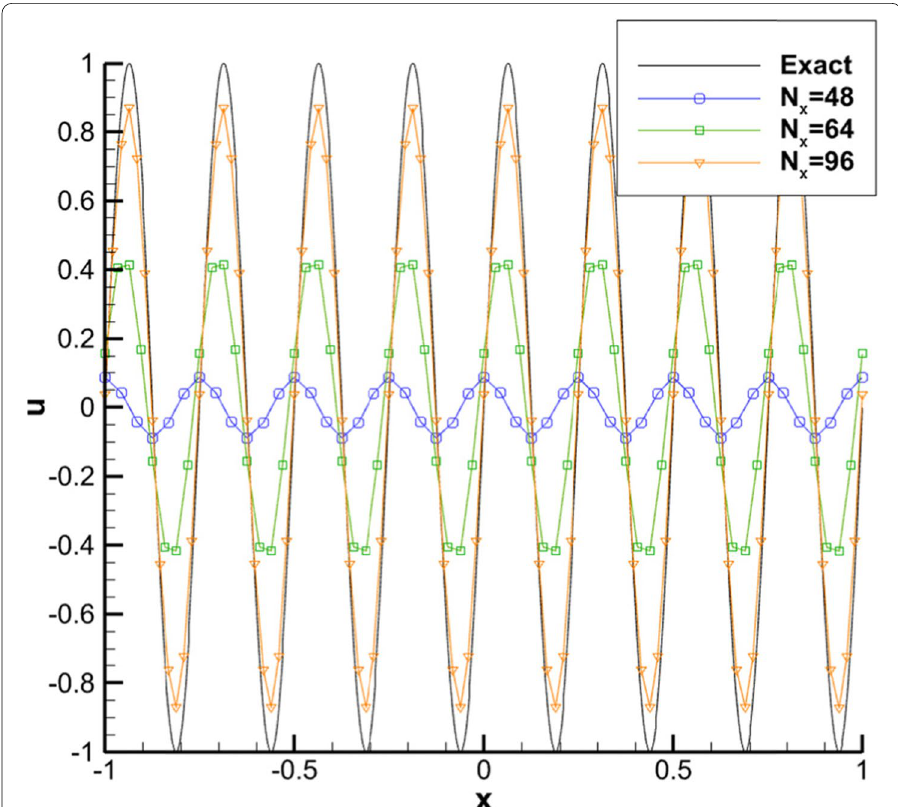
Fig. 6 Results of WENO5-JS with RK 4 for different sizes of grid for T